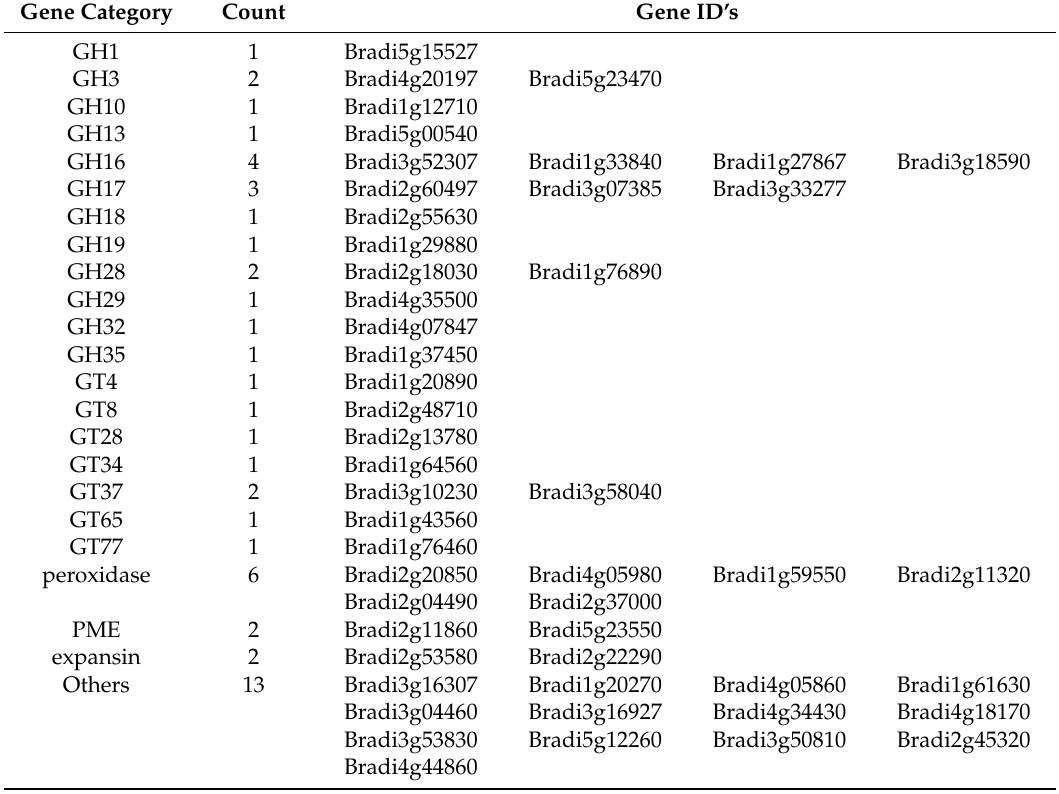
Table 1. Overview of genes associated with enriched GO-terms cluster A +